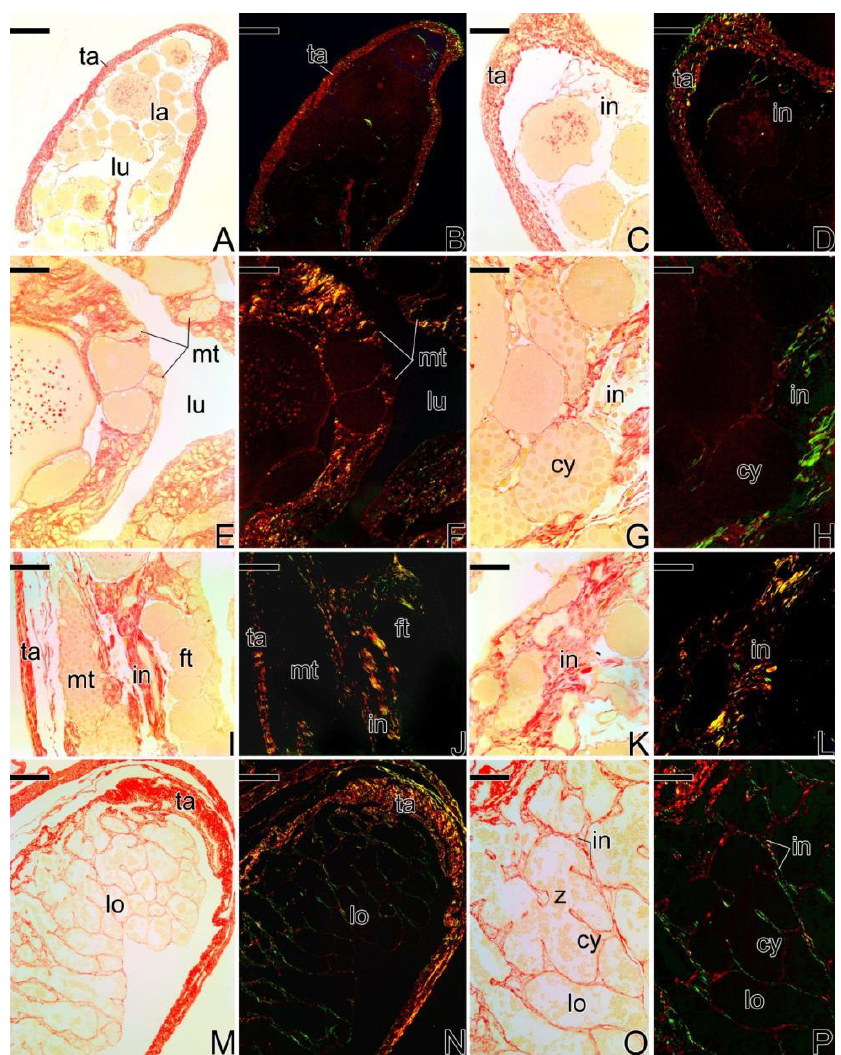
Figure 13. Histological sections of gonads of S. marmoratus showing gonadal remodeling during sex reversal. Picrosirius Red staining. ( A , C , E , G , I , K , M , O ) unpolarized light. ( B , D , F , H , J , L , N , P ) polarized light. ( A – D ). Ovary. Note the collagen fibers in the tunica albuginea are highly birefringent, while those of the interstitium are less birefringent. ( E – H ) Early transitional gonad. The collagen fibers are predominant next to the germinal epithelium, in that the remodeling begins. ( I – L ) Final transitional gonad. The birefringent collagen fibers are now found in the interstitium, in the central region of the gonad. ( M – P ) Testis of secondary male, showing the tunica albuginea defined as in the female. In the interstitial compartment, the organized collagen fibers show the definitive establishment of the germinal and interstitial compartment. Tunica albuginea (ta), ovigerous lamellae (la), ovarian lumen (lu), interstitium (in), male gonadal tissue (mt), female gonadal tissue (ft), testicular lobule (lo), germline cysts (cy), spermatozoa (z). Staining: Sirius red (red) and Picric Acid (yellow). Bar: 300µm ( A , B ), 200μm ( B , C , I , J , M , N ), 100μm ( E , F ), 40µm ( G , H , K , L , O , P ), 250µm ( M , N ). During the development of of primary male testes (Figure 14), the collagen fibers of the tunica albuginea show greenish tones (less mature collagen) and later, reddish tones (more mature collagen). At the interstitium, the fibers become more birefringent as testicular development occurs,